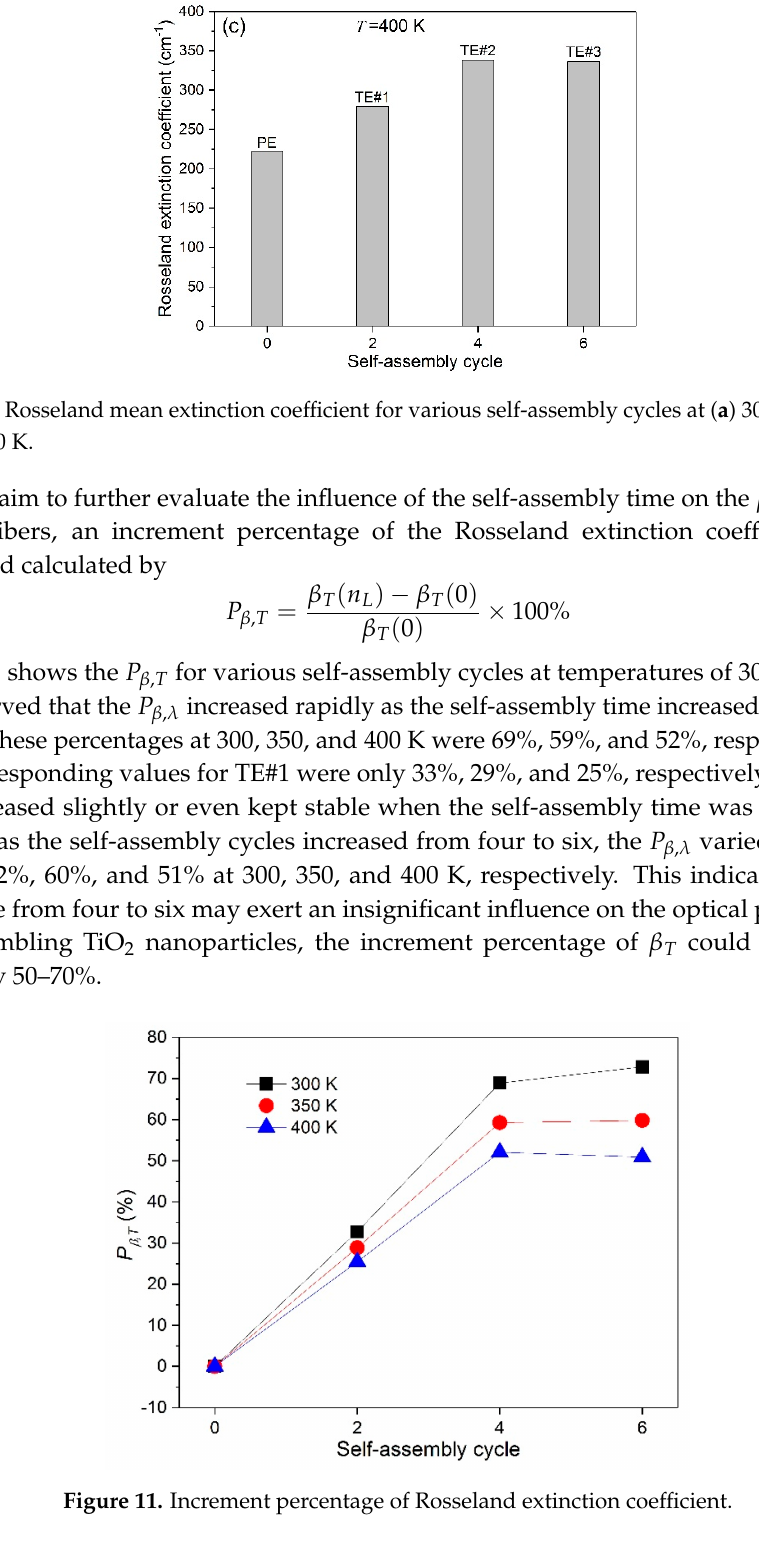
Figure 11. Increment percentage of Rosseland extinction